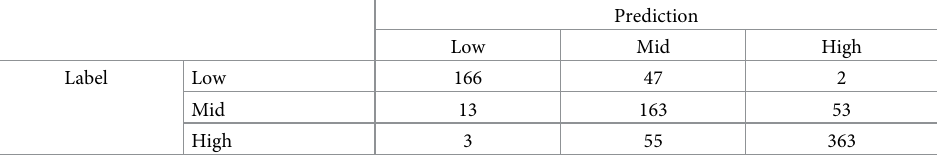
PLOS ONE | https://doi.org/10.1371/journal.pone.0253370 July 9,